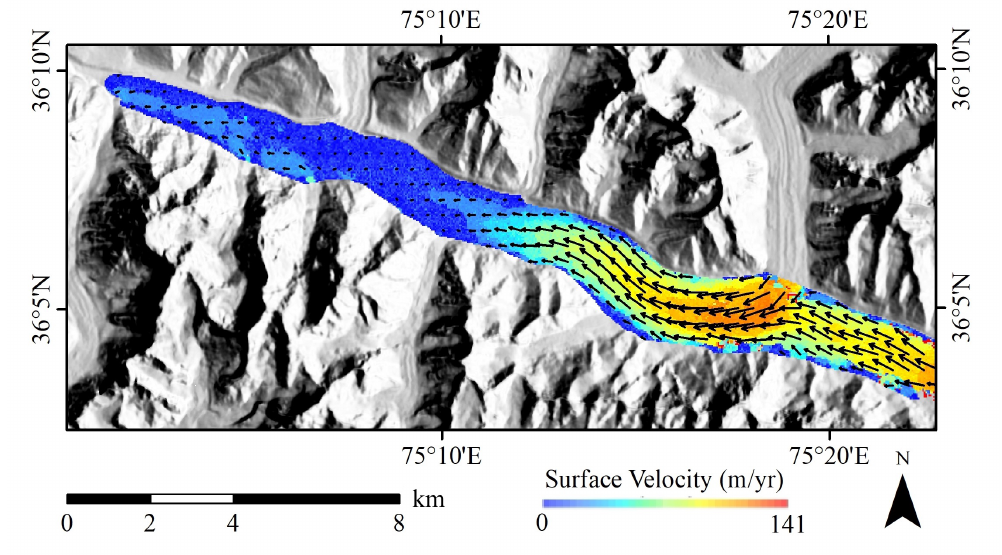
Figure 4. Surface ice-flow velocity field of the Hispar Glacier in the Karakoram estimated using image matching. Two Landsat-7 panchromatic images acquired on 26 June 2001 and 16 August 2002 were processed using the Co-registration of Optically Sensed Images and Correlation (COSI-Corr) software package